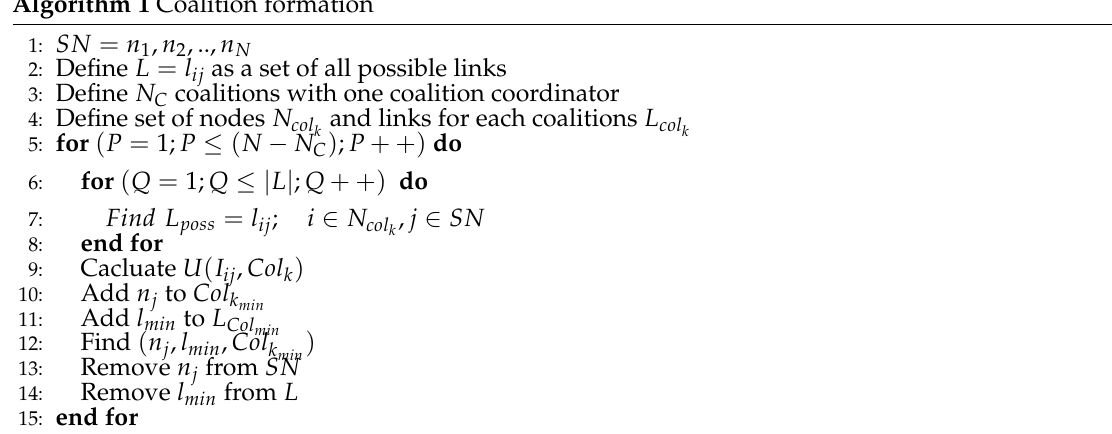
Algorithm 1 Coalition